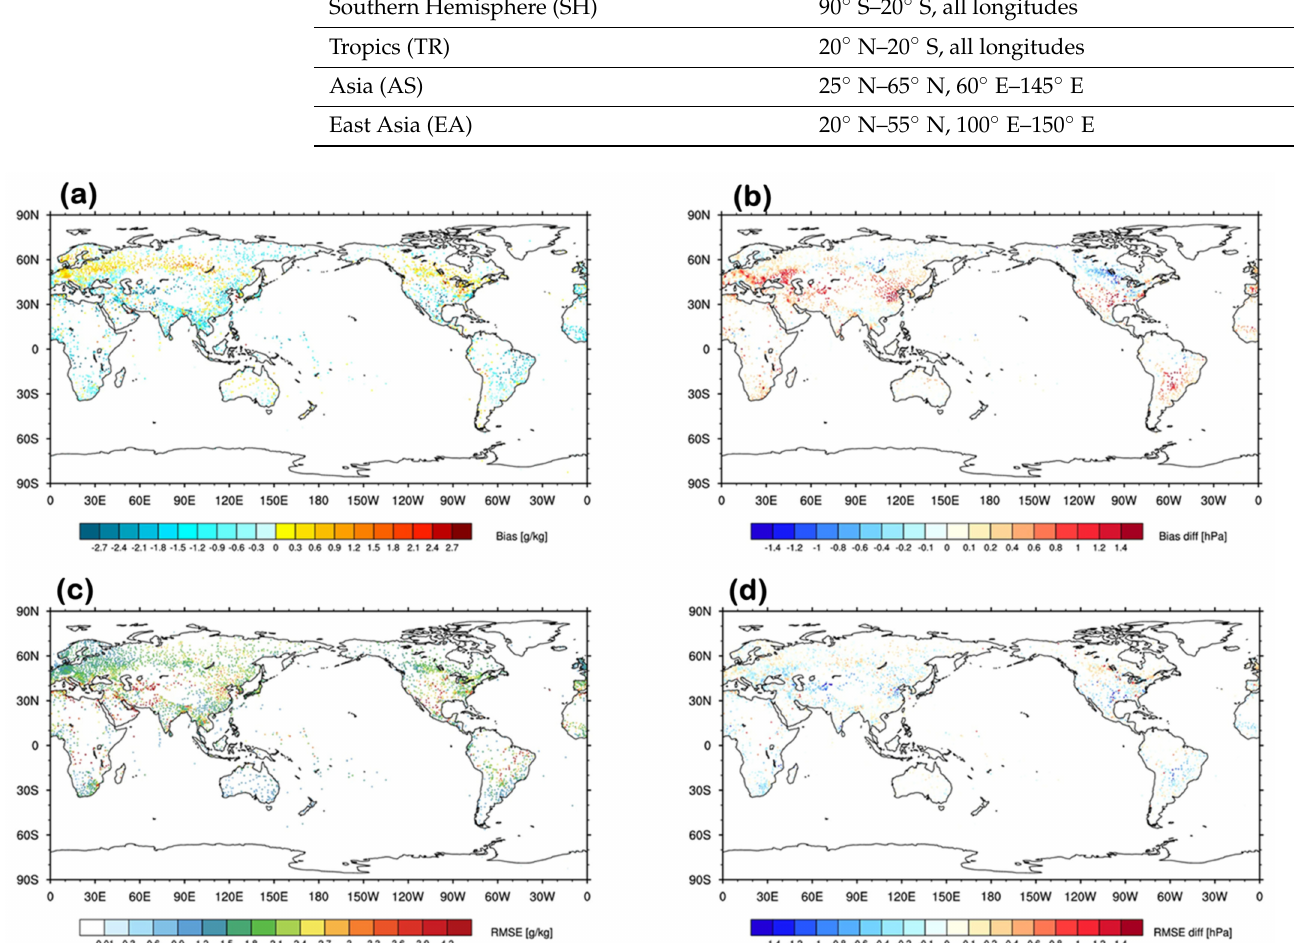
Figure 13. ( a ) Biases and ( c ) RMSEs of near-surface-specific humidity in the CTL against the near-surface observations, and differences in ( b ) biases and ( d ) RMSEs between the EXP and CTL for a five-day